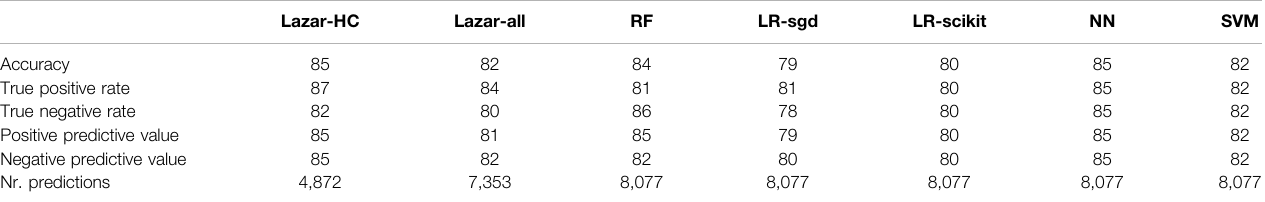
TABLE2| SummaryofcrossvalidationresultswithCDKdescriptors(lazar-HC, lazarwithhighcon fi dence,lazar-all:alllazarpredictions,RF,randomforests,LR-sgd,logistic regression (stochastic gradient descent), LR-scikit, logistic regression (scikit), NN, neural networks, SVM, support vector